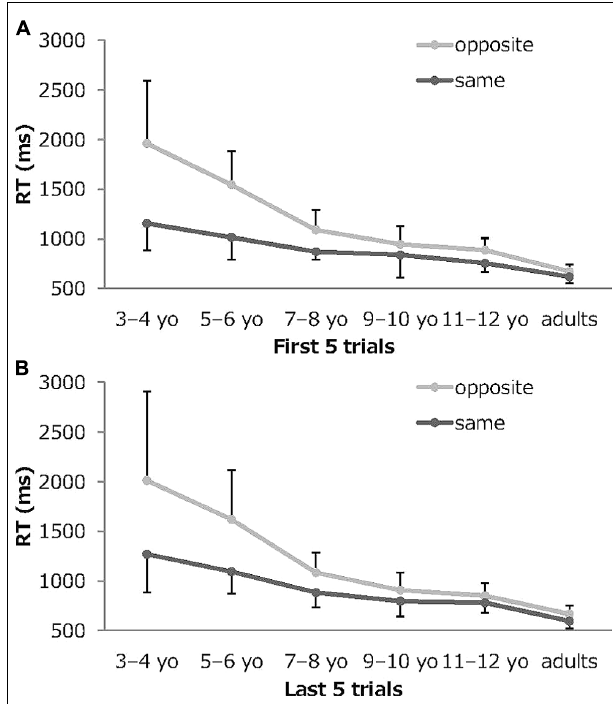
FIGURE 4 | Mean RT early and late in the session in the Stroop-like big–small. (A) mean RT on the first five trials, (B) mean RT on the last five trials. Error bars represent standard